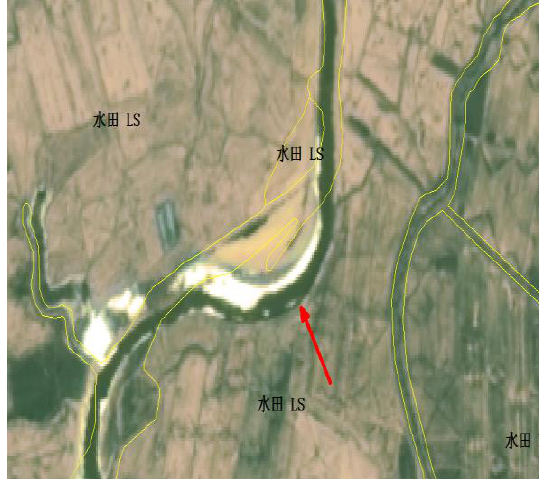
Figure 6. wrong combination of river spots and